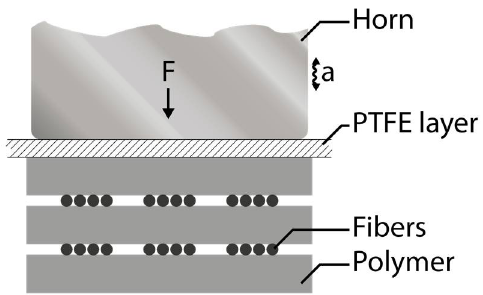
^ Figure 2. General setup used for the ultrasonic impregnation trials, featuring alternating layers of fibers, and polymer films stacked below an ultrasonic horn.